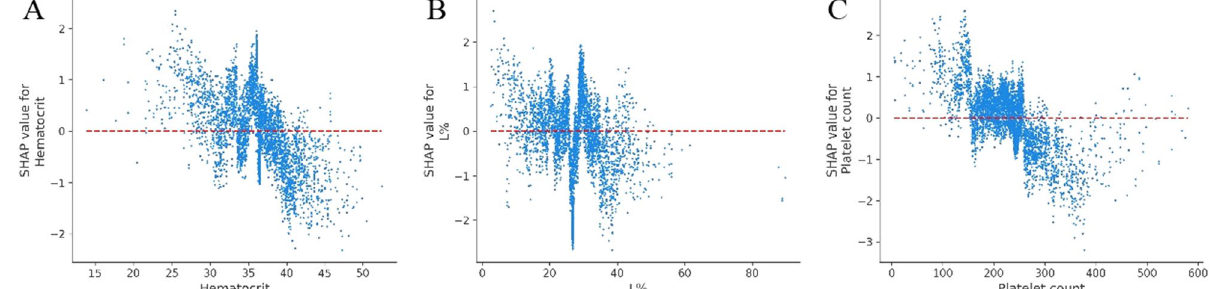
Figure 7. Partial SHAP dependence plots for blood routine. ( A ) Hematocrit. ( B ) L%. ( C ) Platelet count. L: Lymphocyte